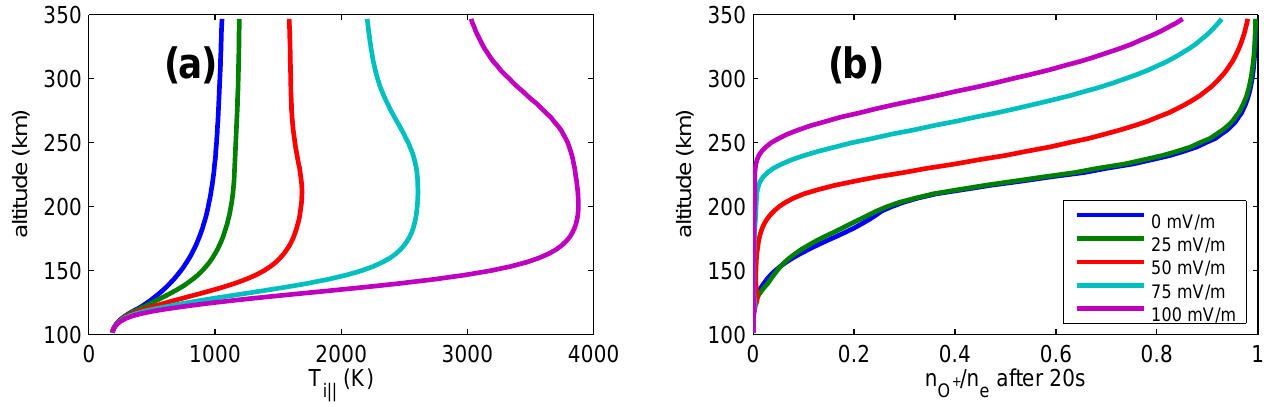
Fig. 3. TRANSCAR simulations of the effects of electric fields of varying intensity on the ionosphere. The legend in panel (b) applies universally to this figure. Panel (a) enhanced parallel ion temperatures. Panel (b) ion composition shown as the fraction of the plasma that is O +